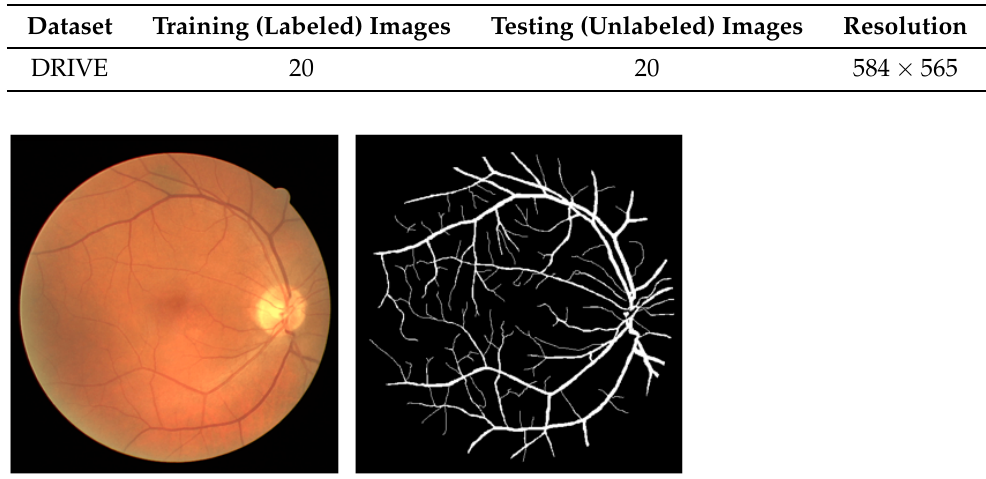
Figure 1. Example of one of the train set images ( left ) and its corresponding label ( right ). The blood vessels are segmented in white and the retinal background in